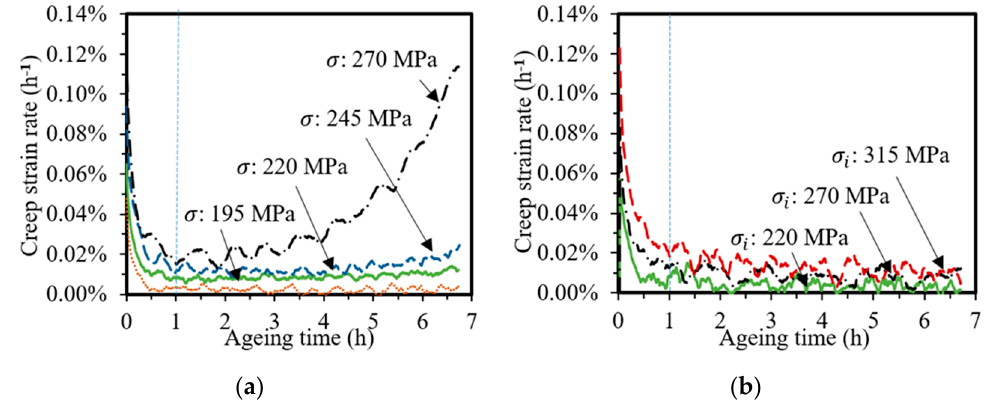
Figure 6. Creep strain rate evolution of ( a ) creep and ( b ) stress relaxations during ageing at 177 °C extracted from Figures 3a,c.